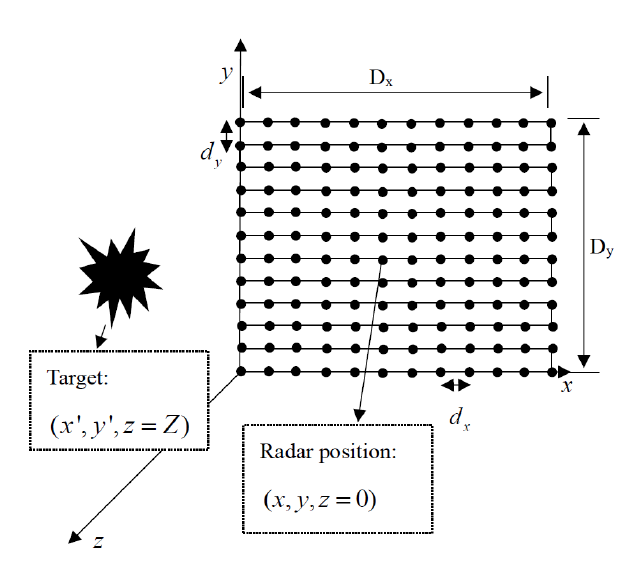
Figure 1. Geometric diagram of two-dimensional scanning synthetic aperture radar in the near- field environment.